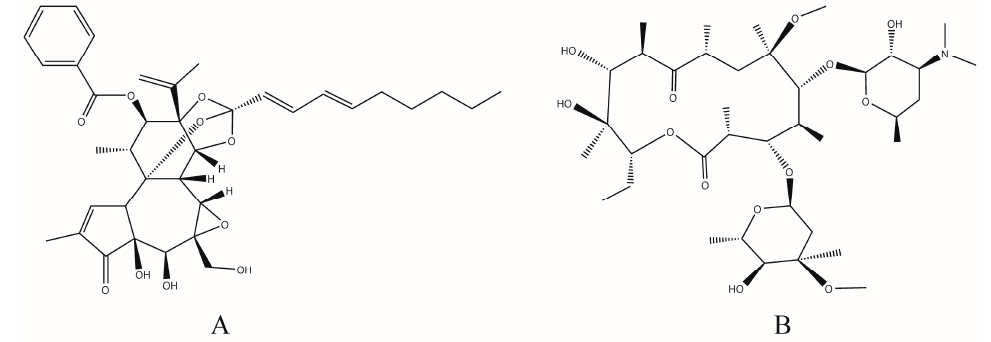
Figure 3. Chemical structures of yuanhuacine ( A ) and IS ( B ).